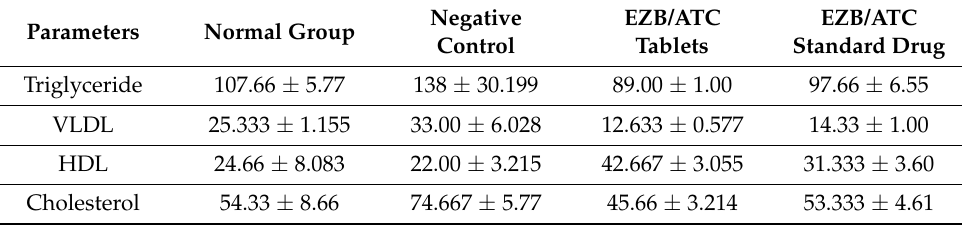
Table 6. Effect of atorvastatin and ezetimibe on lipid profile of rats in curative